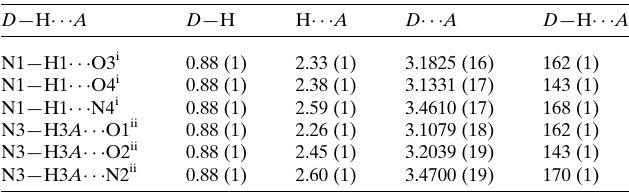
Table 1 Hydrogen-bond geometry (A˚ , (cid:3) ).